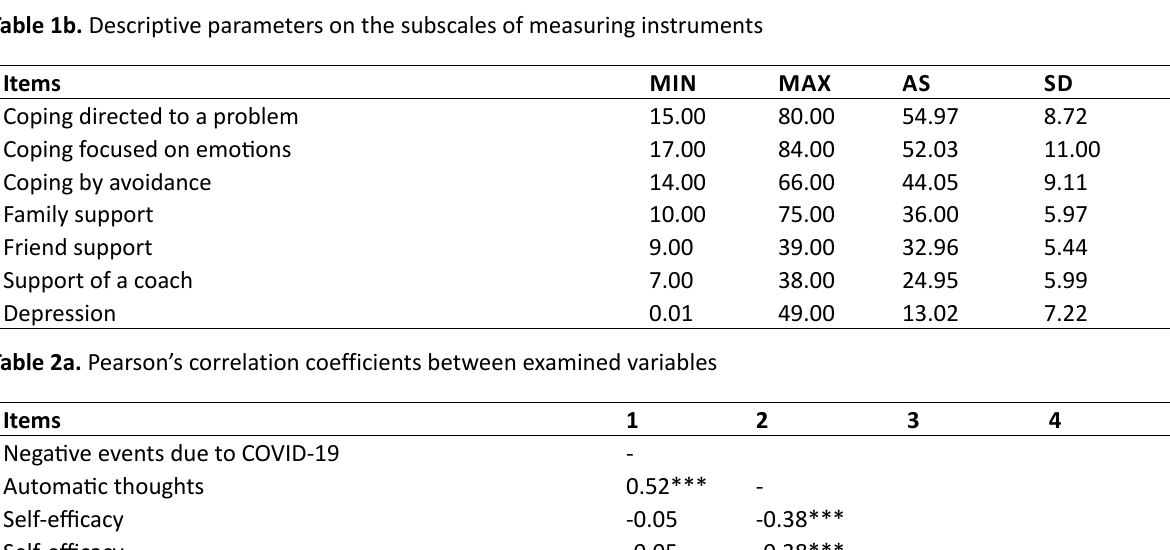
Table 1a. Descriptive parameters on the subscales of measuring instruments ITems Negative events due to COVID-19 Automatic thoughts